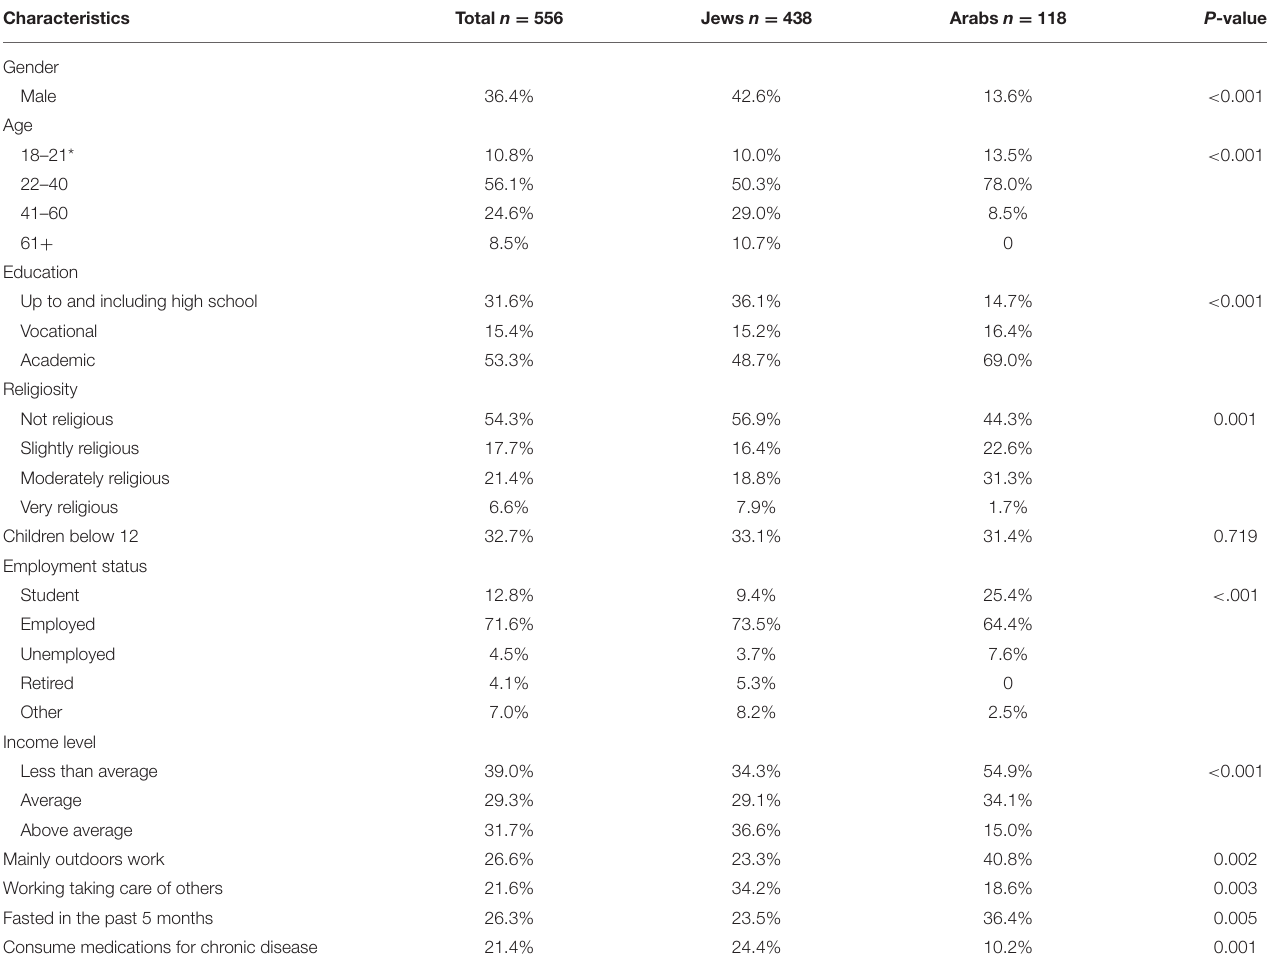
TABLE 1 | Demographic characteristics of the respondents by population